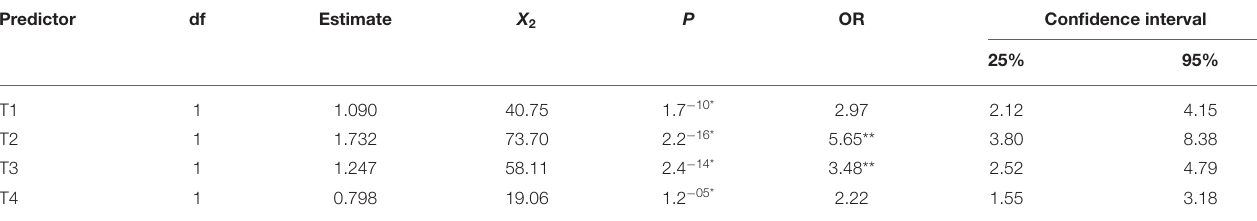
TABLE 2 | Summary of the general linear models (GLMs) of Tectona grandis seedling survival at 30, 60, and 90 days in nursery. Predictor df Estimate X 2 P OR Confidence